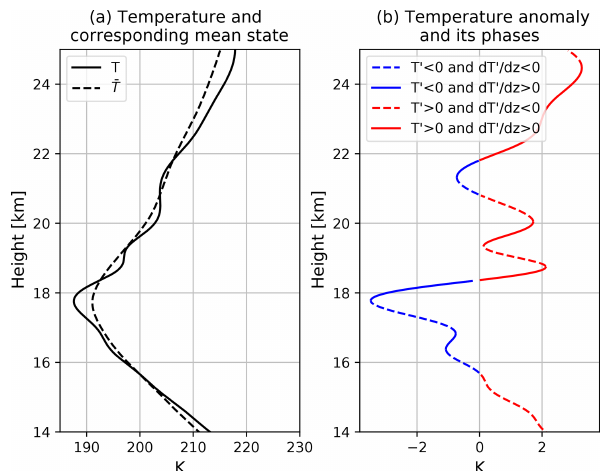
Figure 1. (a) Temperature profile (solid line) from COSMIC at 155 ◦ 43 (cid:48) W, 18 ◦ 16 (cid:48) N on 1 January 2007 and its corresponding mean state (dashed). (b) T (cid:48) of the given profile and its four phases based on the sign of T (cid:48) and d T (cid:48) / d z